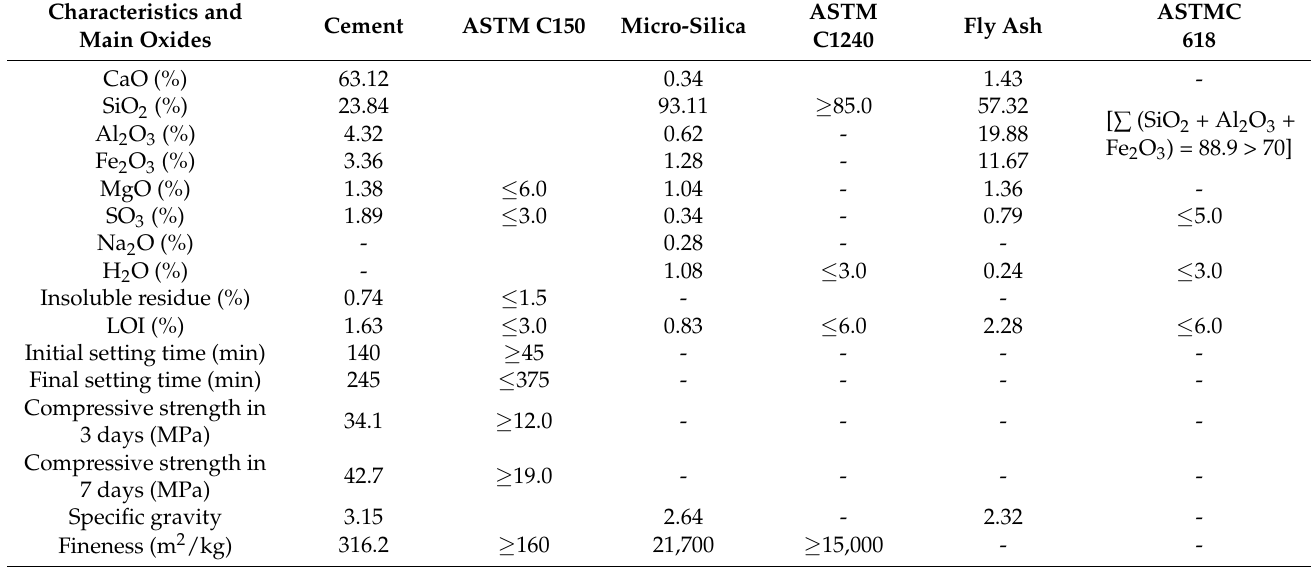
Table 1. Chemical compositions and physical properties of cement, micro-silica, and fly